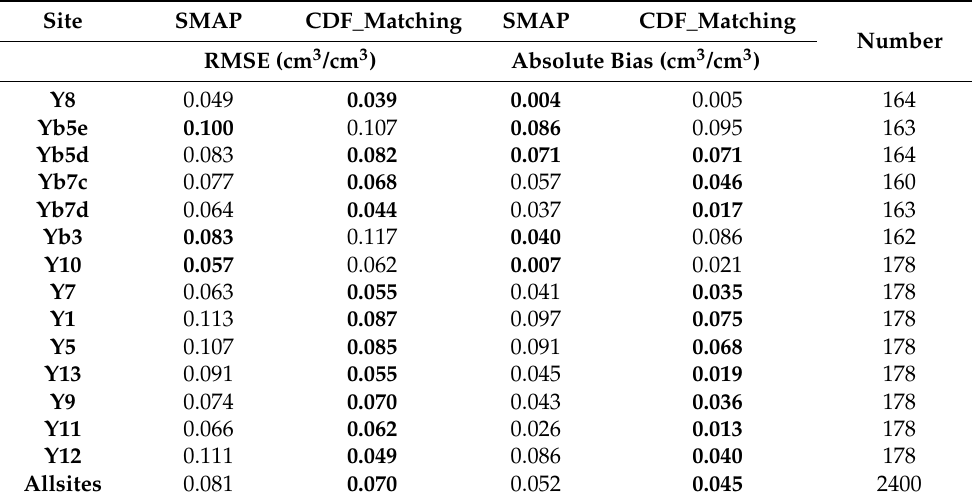
Table 6. Summary of the comparisons among SMAP and CDF matching SSM results over the 12-month study period, with bold numbers denoting the best performance at each in situ validation